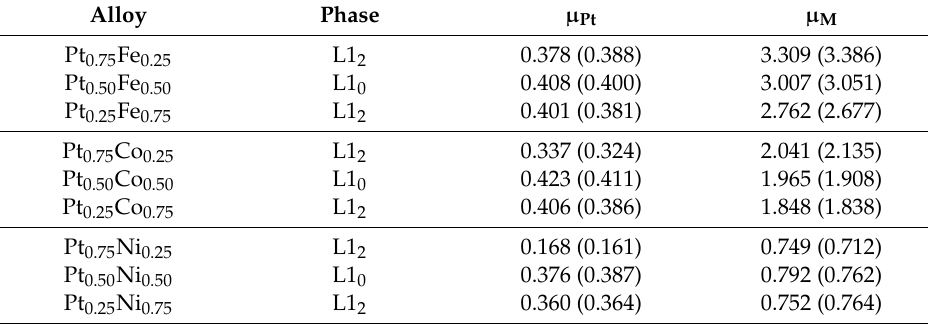
Table 2. Magnetic moments µ Pt and µ M for the Pt and metal (Fe, Co or Ni) atoms, respectively determined in the current work for each of the ordered L1 2 Pt 0.25 M 0.75 and Pt 0.75 M 0.25 alloys, and for the ordered L1 0 Pt 0.5 M 0.5 alloy. The unbracketed and bracketed moments were determined using the Lowdin and projected densities of states (PDOS) methods, respectively (see text). All magnetic moments are in µ B